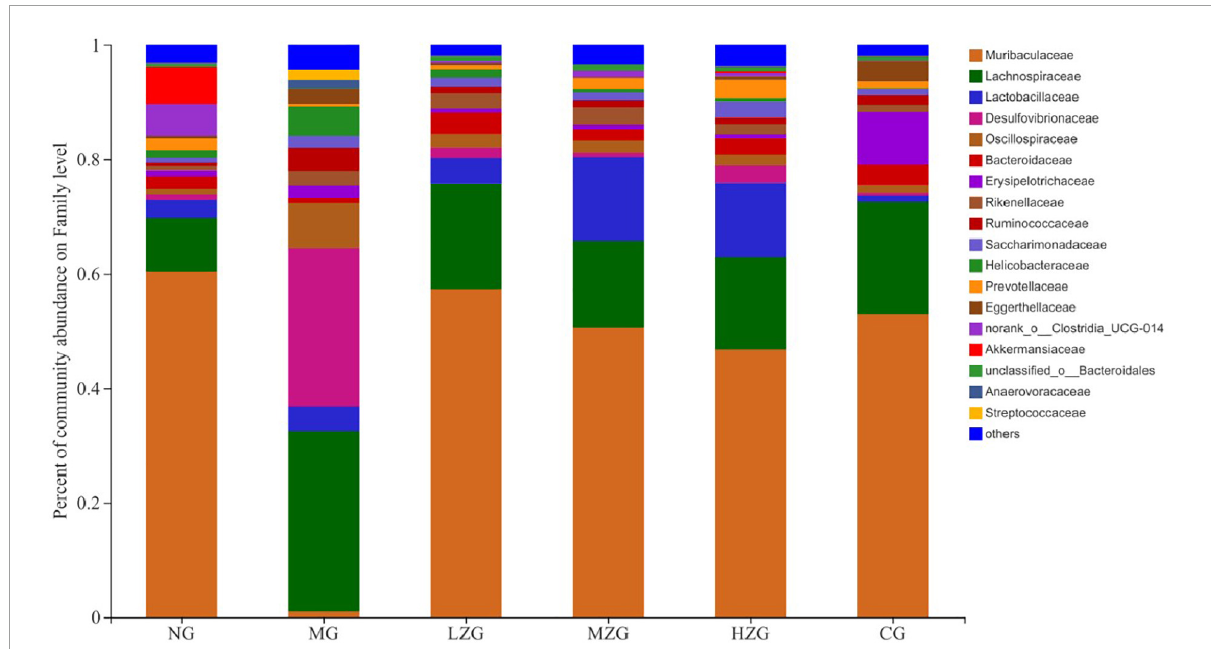
FIGURE6 Gut microbial composition of different samples at the family level. The abscissa is the sample name, the ordinate is the proportion of the species in the sample, the columns with different colors represent different species, and the length of the columns represents the proportion of the